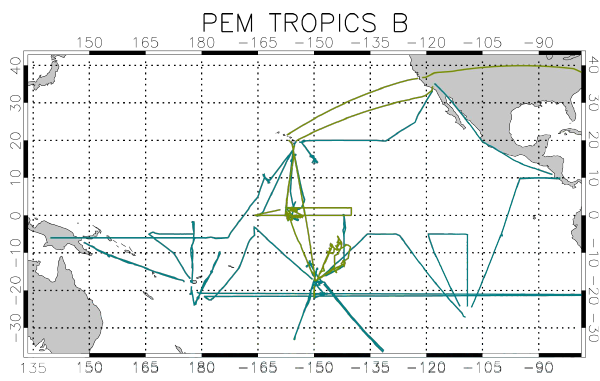
Fig. 6. The flight routes of taken by the DC-8 (cyan) and P-3B (green) during March 1999 as part of the PEM-B Tropics